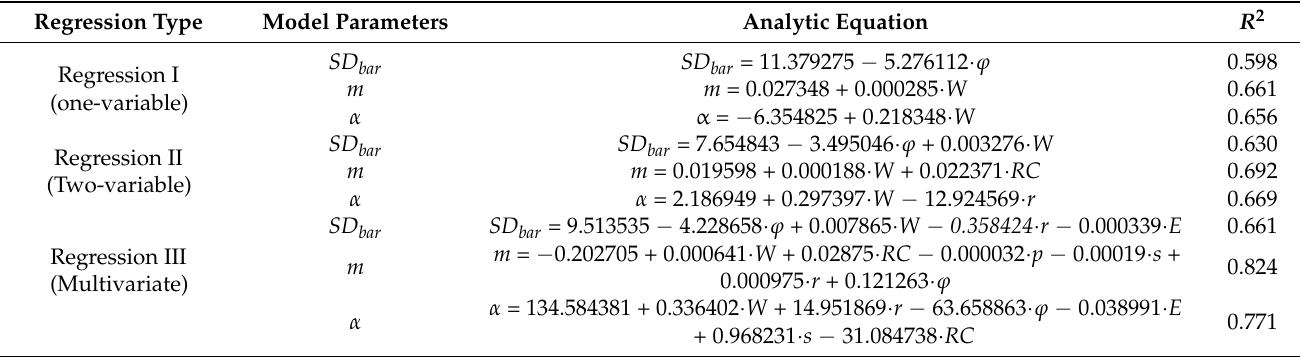
Figure 3. Correlation diagram of BTOP model parameters and watershed characteristic factors (R > 0.6). All data are normalized by the Min-Max normalization approach. The y-axis represents the normalized value of ( a ) SD bar ’ ; ( b ) m’ ; ( c ) α ’. The x-axis represents the normalized value of watershed characteristic factors. Table 5. Regression equations of model parameters and attribute characteristics of research basins and their fitting evaluation